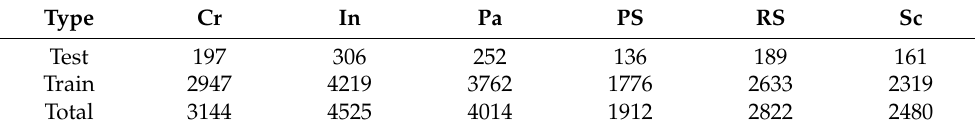
Table 1. Defect instance distribution of six defect types in train and test sets.